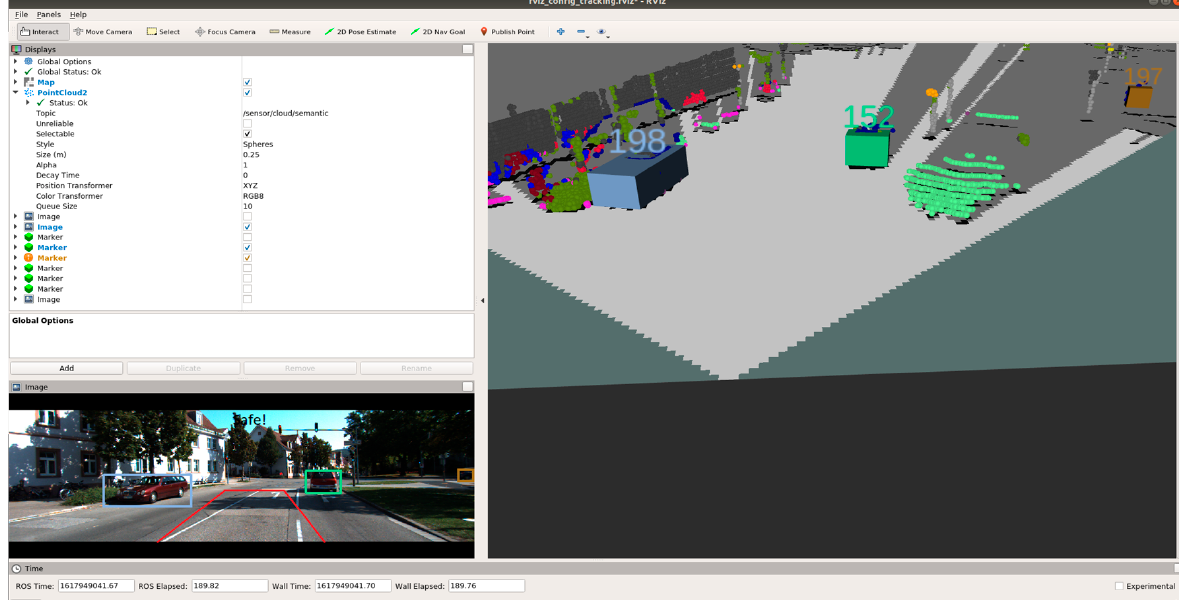
Figures 24 and 25 depicts a safe scenario in which no target objects are present in the